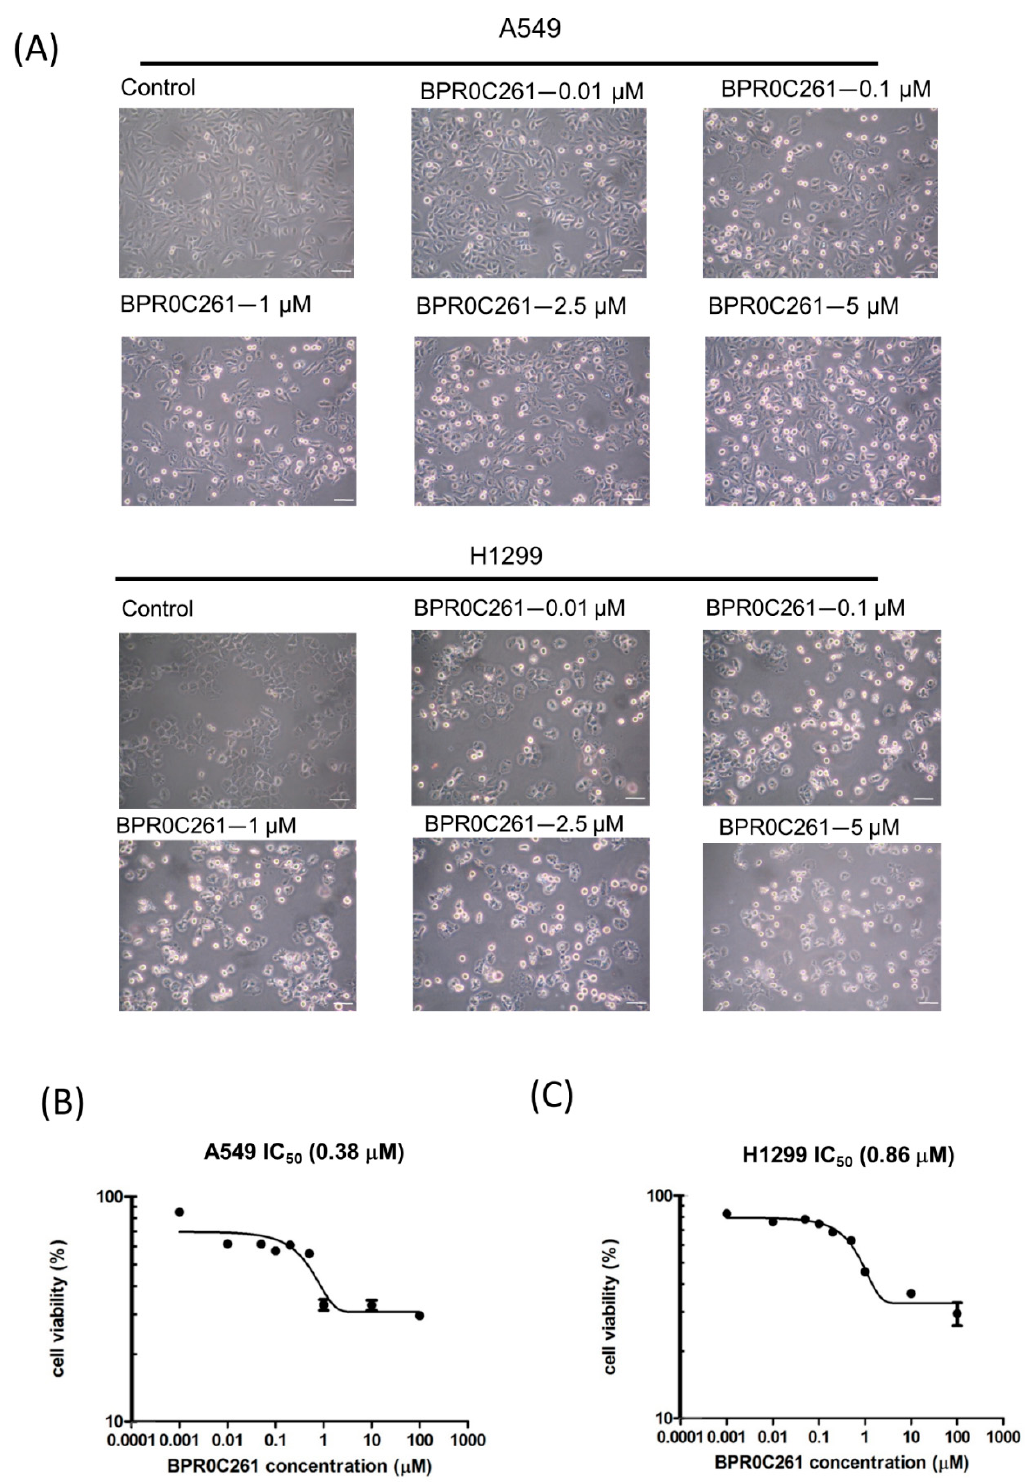
Figure 1. Cytotoxic effects of BPR0C261 on NSCLC cells. ( A ) Microscopic visualization of cell morphological changes by BPR0C261. Magnification: 40 × ; scale bar: 100 m. ( B , C ) The MTT assay for estimation of IC 50 of BPR0C261 on A549 cells and H1299 cells after 24 h of treatment, respectively.